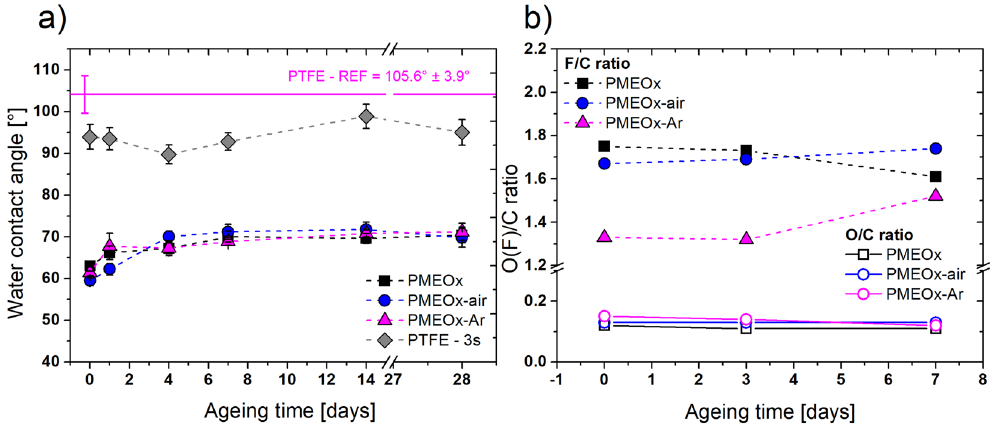
Figure 5. WCA and chemical composition development during storage. ( a ) WCA values of washed PMEOx coatings and their ageing behavior during the 28 days of storage compare to raw PTFE treated by plasma at 3 s; ( b ) Changes in O/C and F/C ratios of PMEOx coatings during the 7 days of